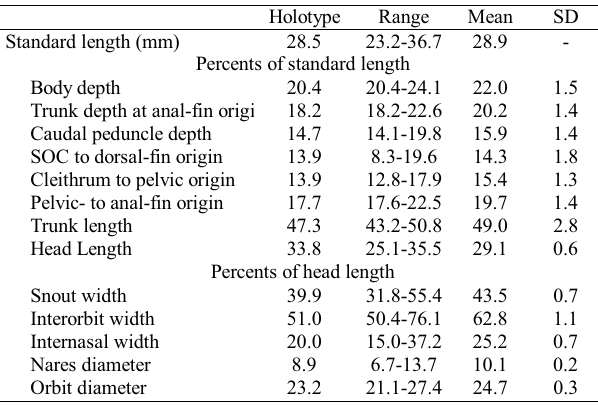
Table 2. Morphometric data for Otocinclus batmani . Values are given for the holotype (ICNMHN 6721) and nine paratypes (n = 10). SOC = supraoccipital posterior